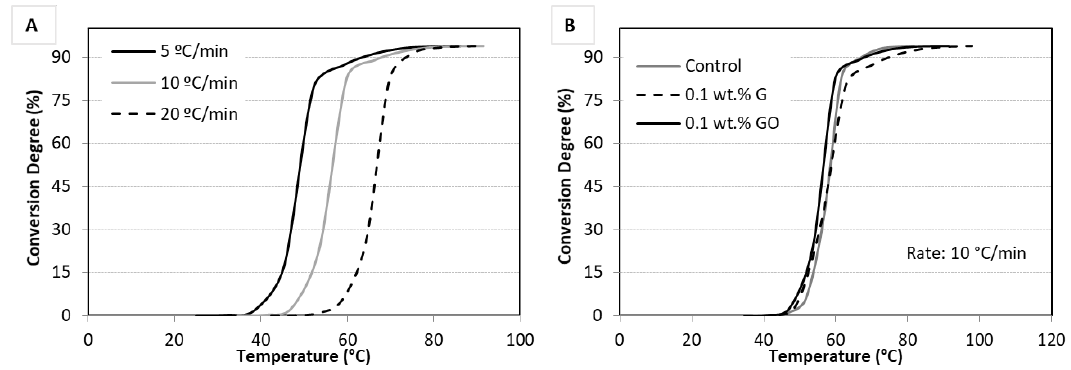
Figure 2. Conversion degree curves for ( A ) polymethyl methacrylate (PMMA) bone cement with 0.1 wt.% GO powder when subjected at the different heating rates and ( B ) the different bone cement types tested at a heating rate of 10 °C/min.